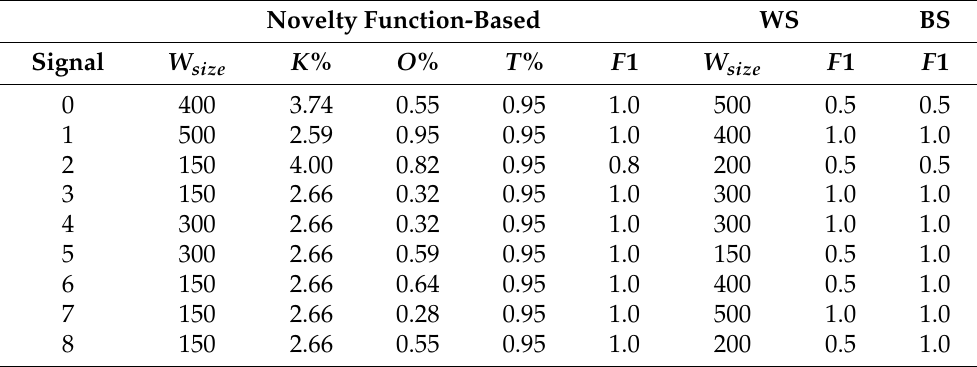
Table A3. Parameter configuration and experimental results of each signal in Dataset 2 (ECG1, see Section 3.2). W size : window size; K %: kernel size in percentage of the window size; O %: overlap percentage of the window size. T %: amplitude threshold for event detection; WS: window-based segmentation; BS: binary segmentation. The tolerance used to calculate the F1-score ( F 1) equals the window size for novelty function